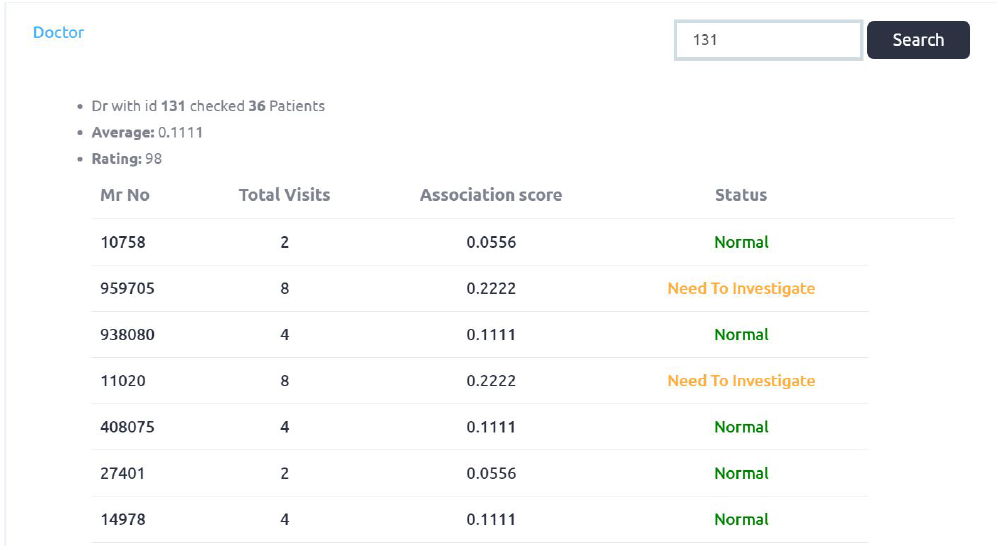
Figure 9. Doctor with respect to Patient association scores.